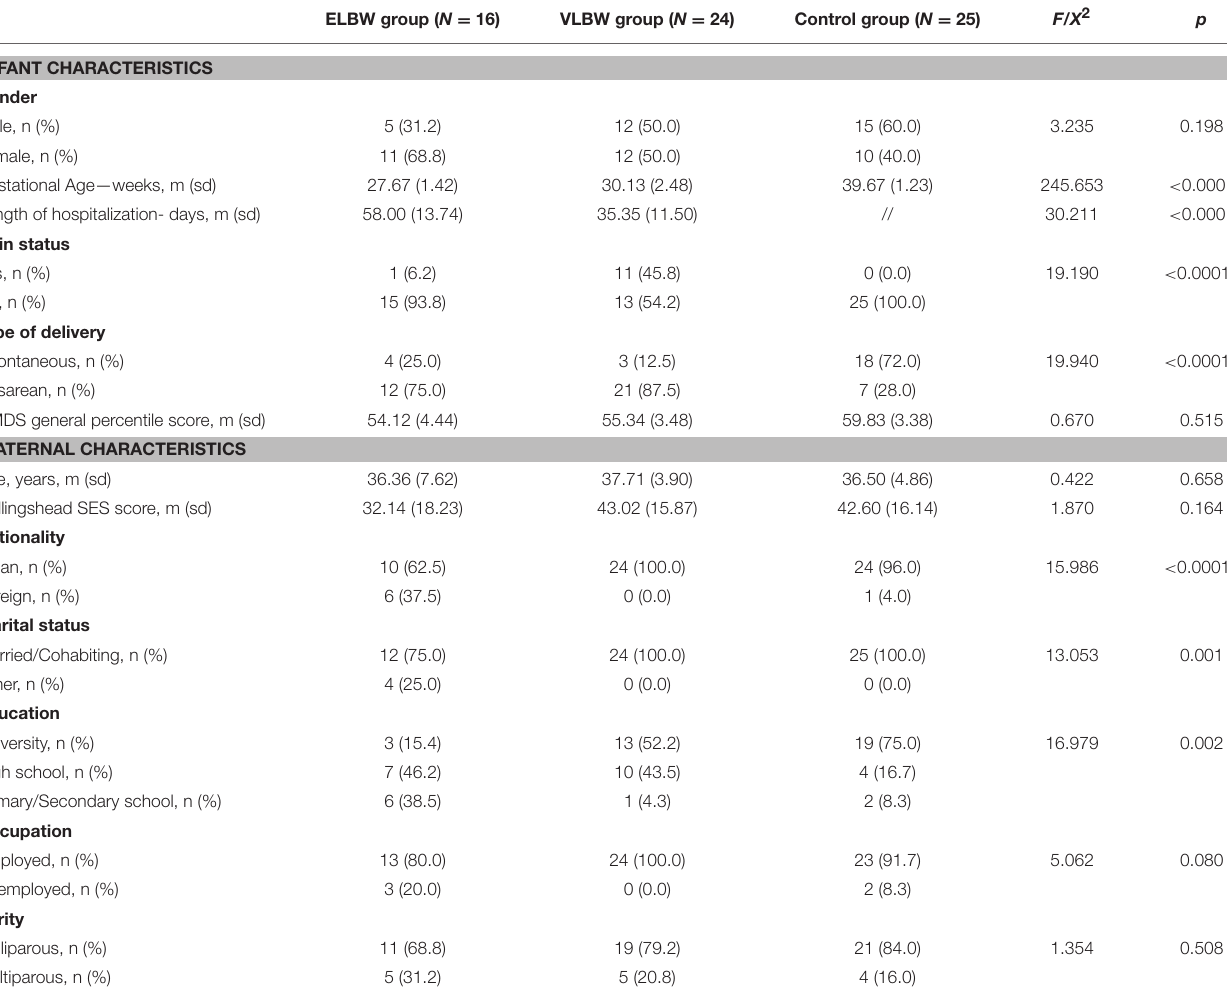
TABLE 2 | Infant and maternal socio-demographic and clinical characteristics. ELBW group ( N = 16) VLBW group ( N = 24) Control group ( N = 25) F/X 2